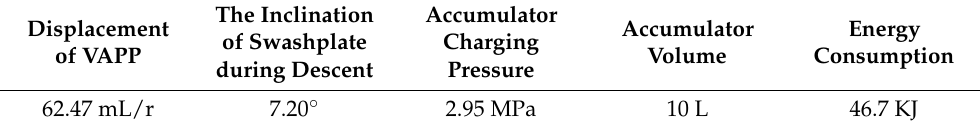
Table 3. The optimized potential-energy-recovery system parameters.